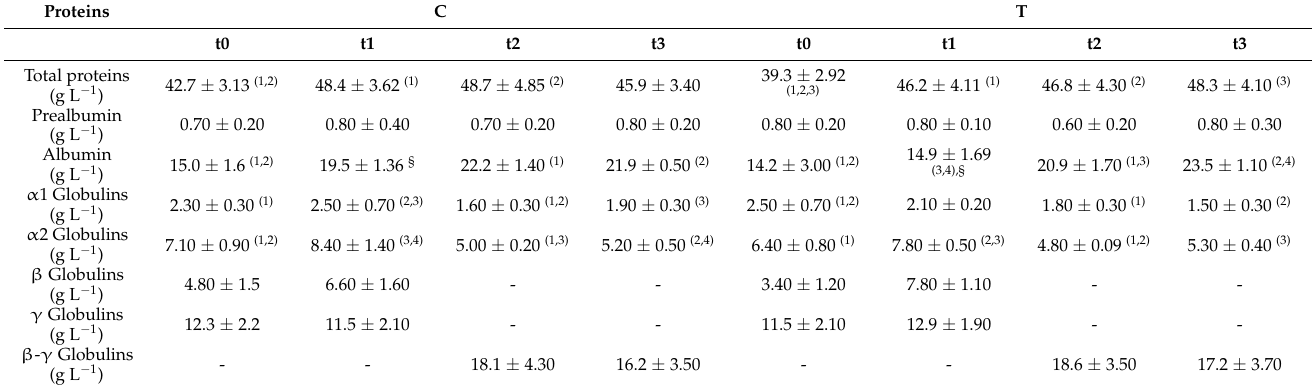
Table 2. Concentrations of serum protein fractions determined after agarose gel electrophoresis in control (C) and supplemented (T) hens at different experimental time points: t0, start of the trial; t1 (5th week), before the start of laying; t2 (12th week), end of the supplementation; t3 (19th week), end of the trial. Data are reported as mean ± SD (n = 8 for each